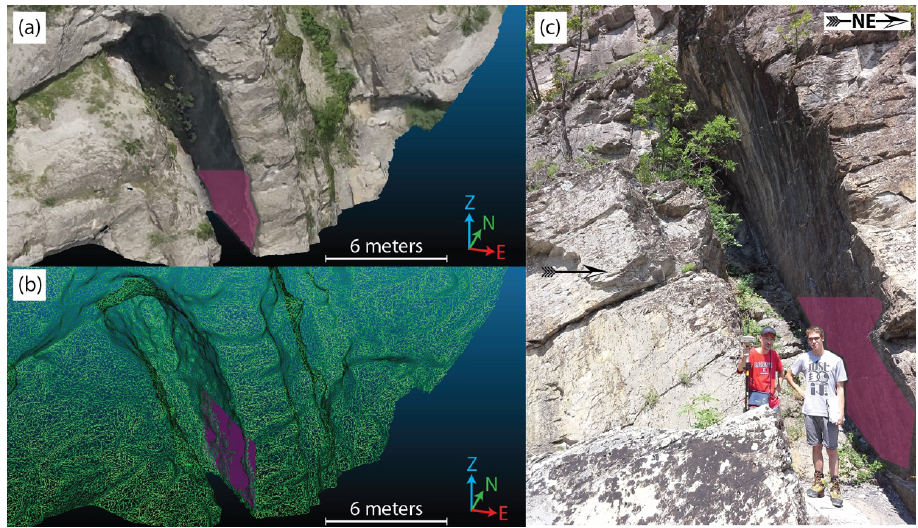
Figure 6. ( a ) Textured digital outcrop model (TDOM), ( b ) triangular mesh and ( c ) field survey picture of the same portion of the outcrop 1 (peoples for scale). In ( a , c ) the surface representing the control plane ‘C’ are shaded in purple. In ( b ) the best-fit plane calculated using Cloud Compare are represented by a purple rectangle.